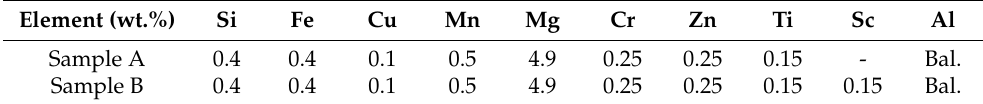
Table 1. Chemical compositions of the fabricated Sc-free/microalloyed Al5083 alloys. Element (wt.%) Si Fe Cu Mn Mg Cr Zn Ti Sc Al Sample A 0.4 0.4 0.1 0.5 4.9 0.25 0.25 0.15 - Bal. Sample B 0.4 0.4 0.1 0.5 4.9 0.25 0.25 0.15 0.15